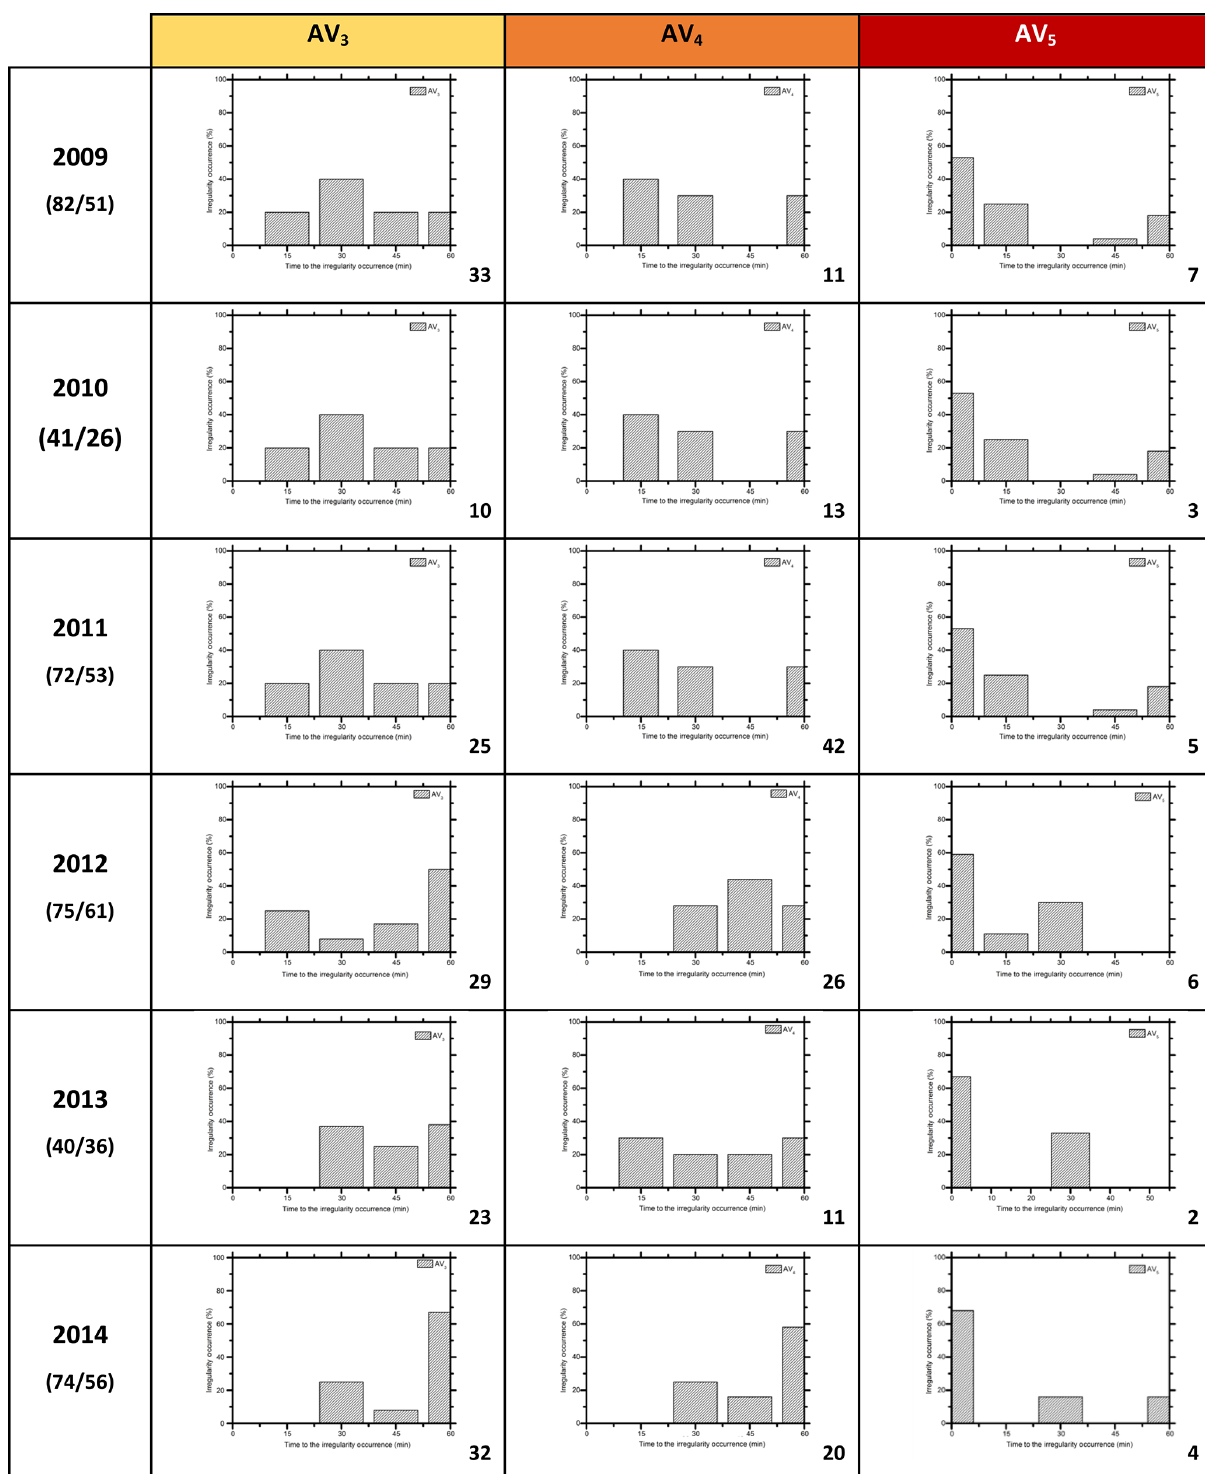
Figure 6. The time relationship between the V zp parameter, considering the AV 3 , AV 4 , and AV 5 indexes, and the irregularity observations in ionograms in the summer of 2009 until 2014 over São